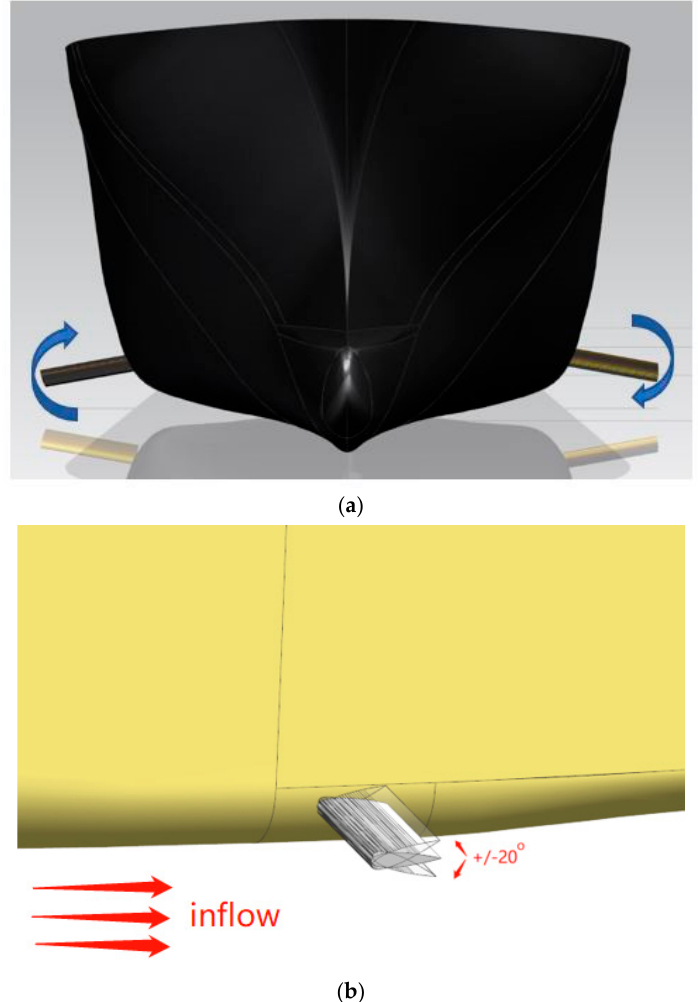
6 of 23 Figure 4. Ship model with a pair of fin stabilizers.